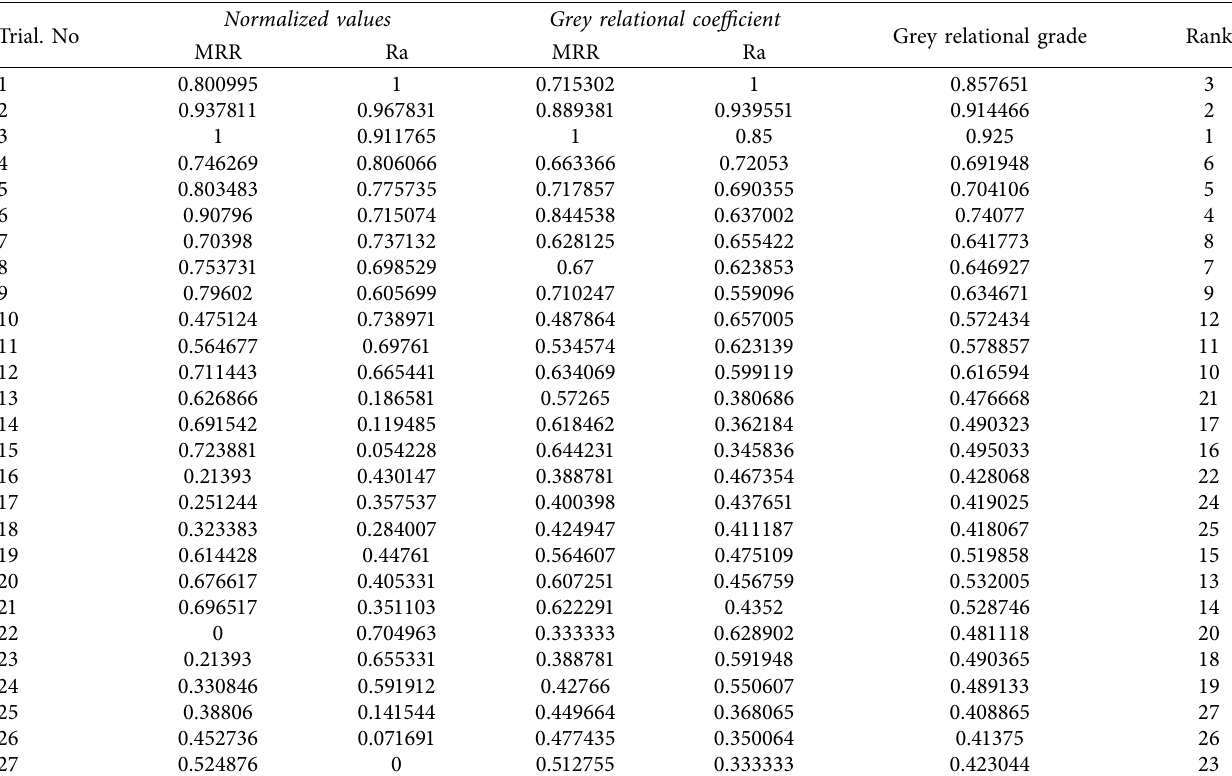
Table 6: Calculated GRG and its order in the optimization